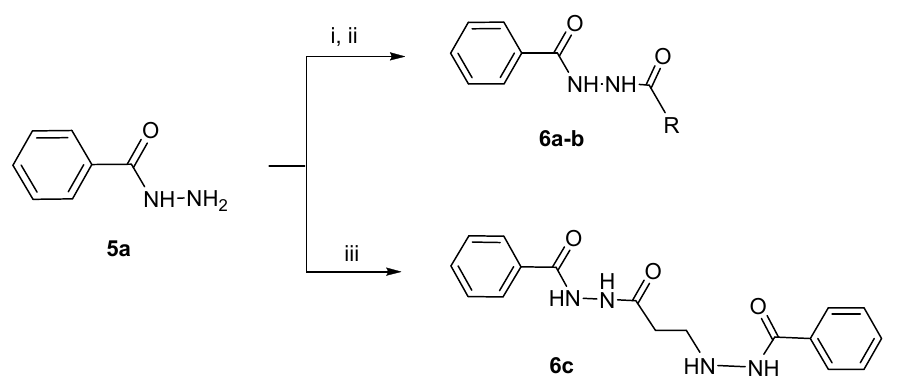
Scheme 2. Synthesis of 6a – c . The reagents used are as follows: i = (C 2 H 5 CO) 2 O for 6a , ii = (CH 3 CO) 2 O for 6b , and iii = 1a for 6c . X: The alkyl groups are as follows: a = C 2 H 5 ; b = CH 3 .